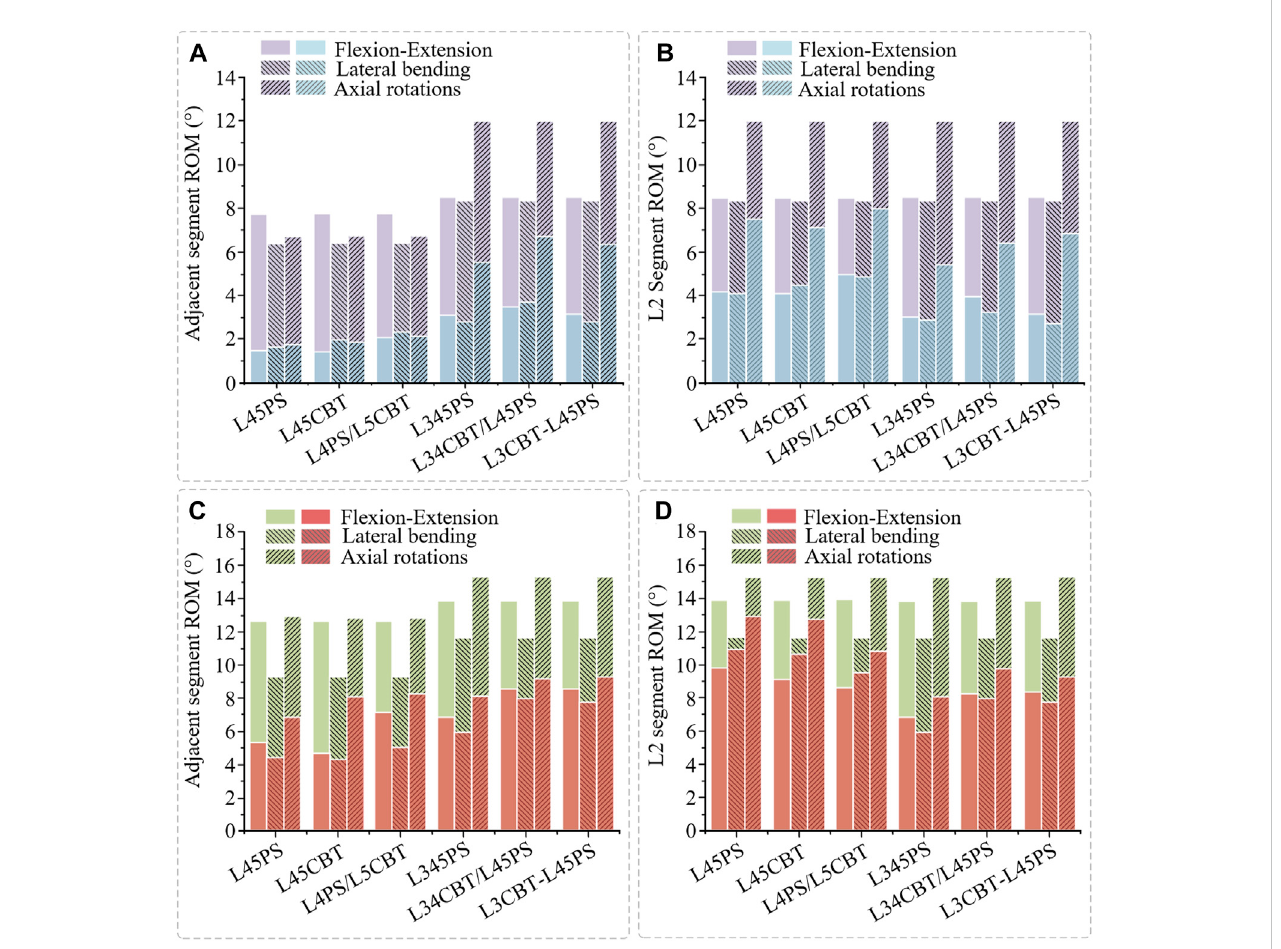
FIGURE 6 Adjacent-segment ROM and L2-segment ROM. (A) Comparison of adjacent-segment ROM, between postoperative FEMs (blue column) and the intact FEM (purple column). (B) Comparison of L2-segment ROM, between postoperative FEMs (blue column) and the intact FEM (purple column). (C) Comparison of adjacent-segment ROM, between postoperative IVEs (red column) and the intact IVE (green column). (D) Comparison of L2-segment ROM, between postoperative IVEs (red column) and the intact IVE (green